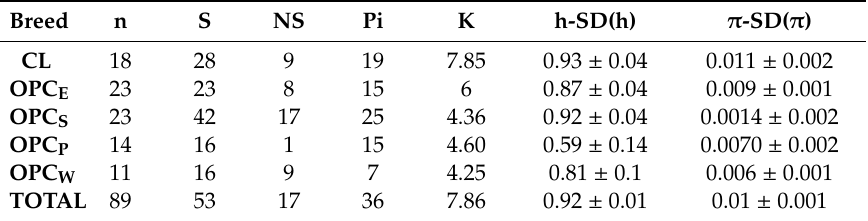
Table 2. Haplotype distribution and frequency in Colombian Creole sheep. n—number of